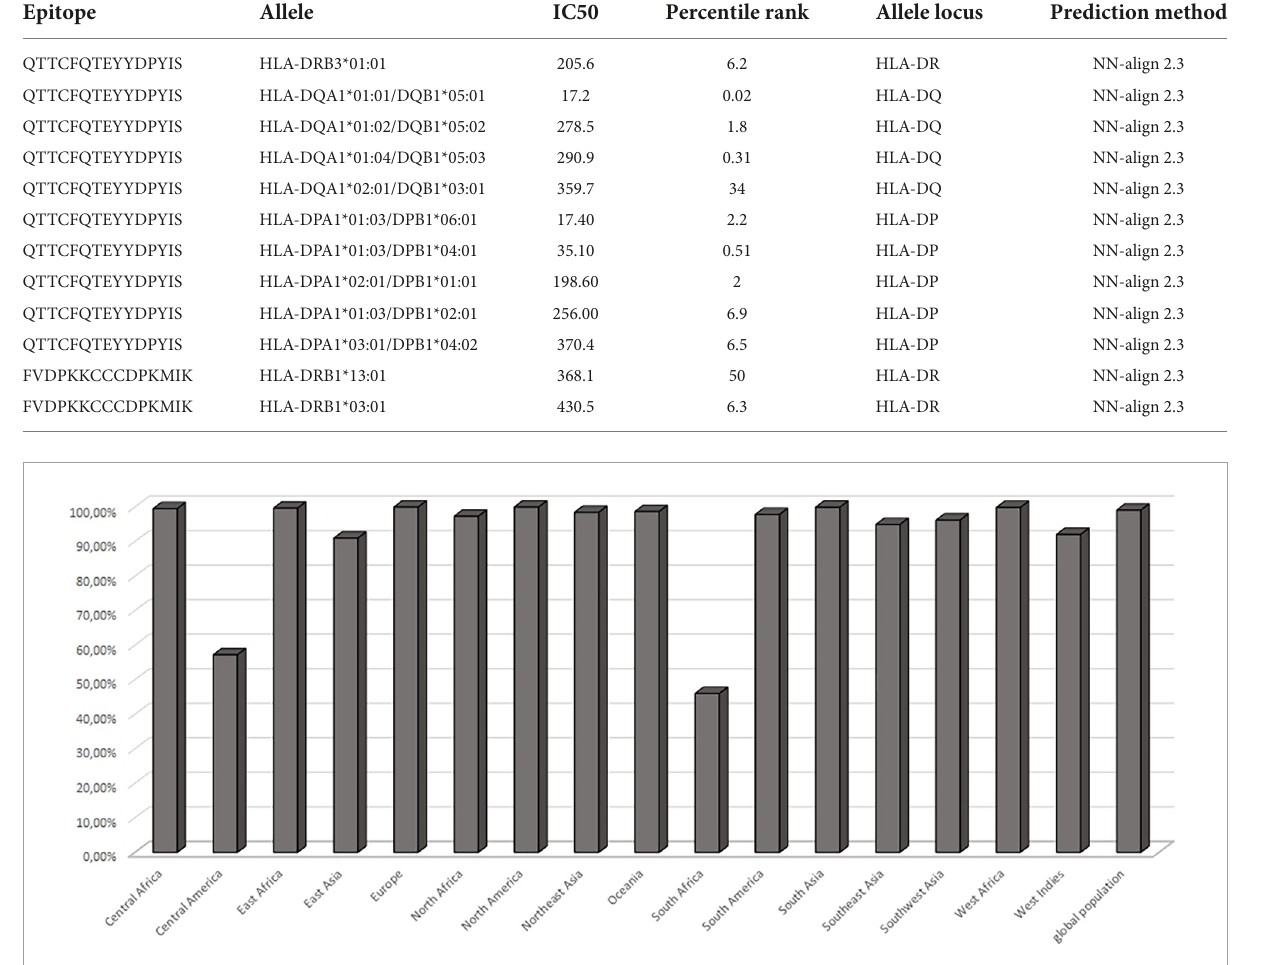
FIGURE4 Population coverage. Cumulative population coverage for both predicted epitopes QTTCFQTEYYDPYIS and